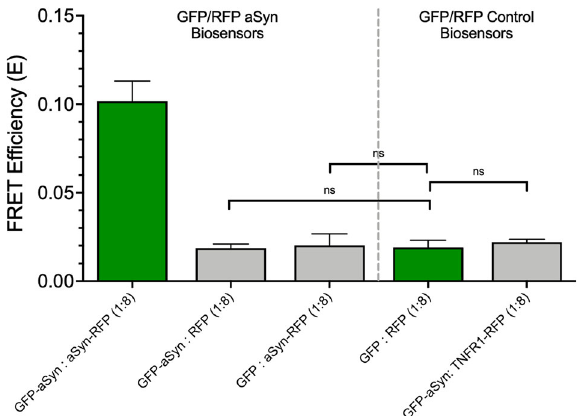
Fig. 4 XFP fusion does not contribute signi fi cantly to background FRET signal. One of the major concerns with any tagged or fusion protein assay are the potential of non-speci fi c protein – protein interactions being driven via the XFP or fl uorescent tag. Here we compared our inter-protomeric α SN cellular FRET biosensor with soluble mEGFP/TagRFP at the same D:A ratio as well as hetero- biosensor combinations to explore potential non- α SN-driven FRET. GFP- α SN to soluble RFP, soluble GFP to α SN-RFP, and GFP- α SN to TNFR1-RFP systems demonstrate little to no difference from soluble GFP/RFP systems. We conclude that the signi fi cant FRET in the inter- protomeric biosensor relative to soluble GFP/RFP is therefor due to direct α SN – α SN interactions. ns indicates no signi fi cant difference as determined by Student ’ s t